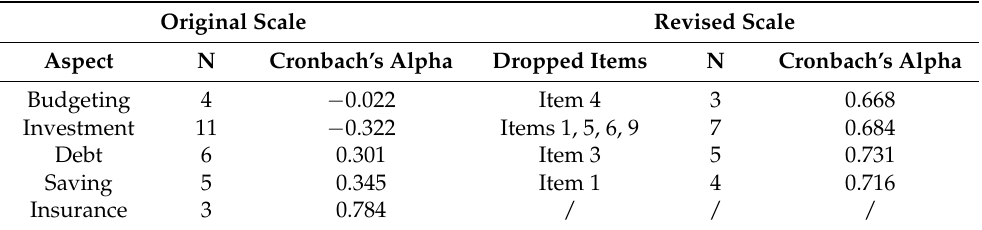
Table 2. Cronbach’s alpha coefficients ( n = 887).